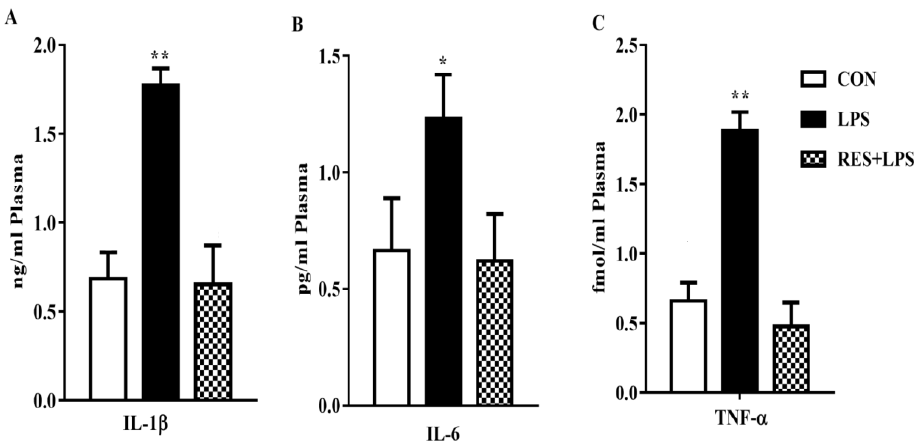
Figure 3. Concentration of proinflammatory cytokines in mammary tissue of female mice: ( A ) IL-1 β , ( B ) IL-6, and ( C ) TNF- α . * p < 0.05 significant and ** p < 0.005 highly significant.